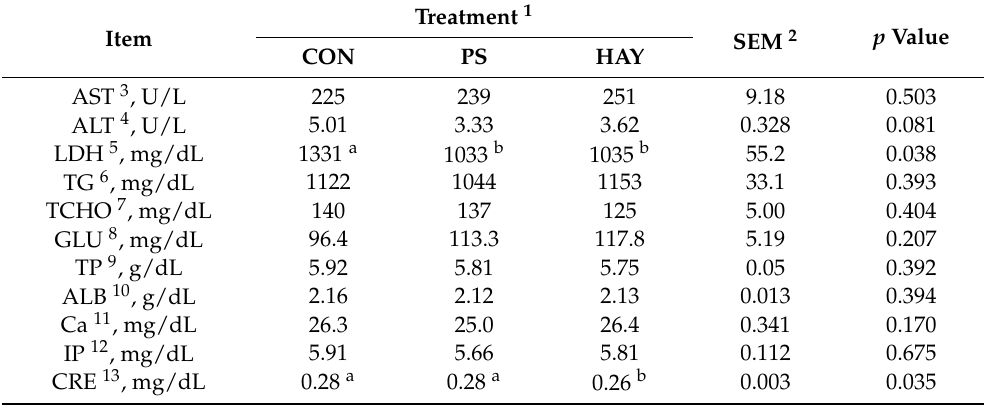
Table 3. Means of blood variables of laying hens according to environmental enrichment materials.